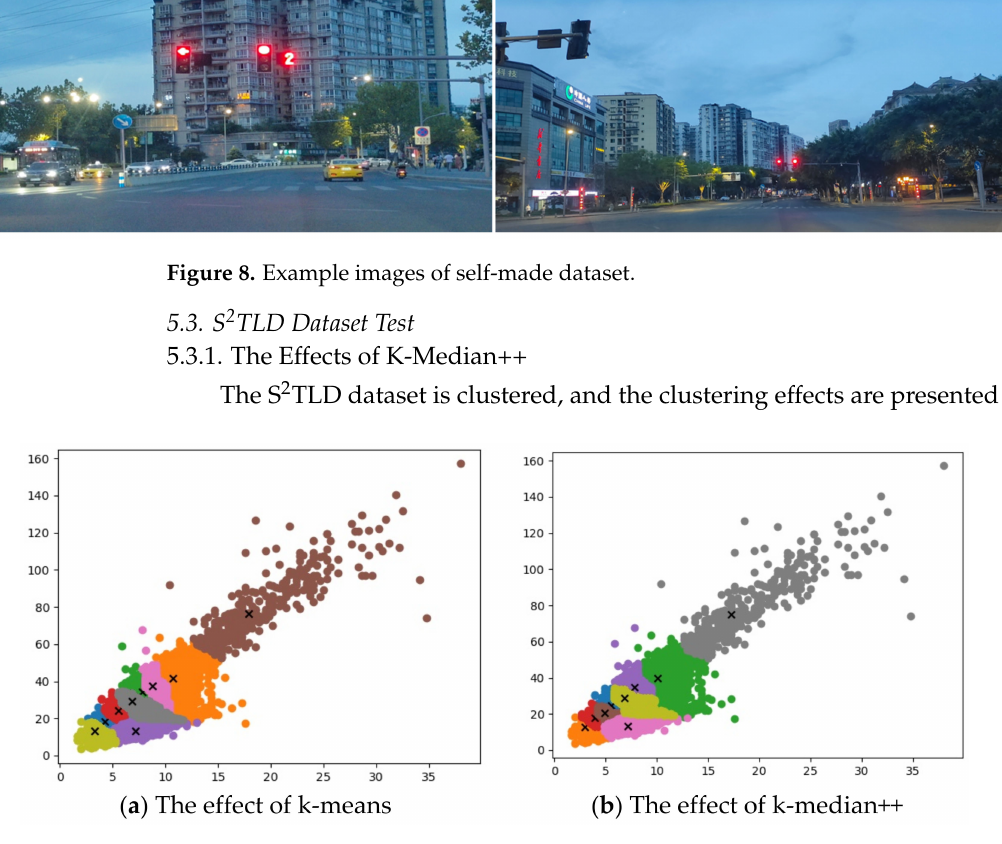
Figure 9. The effects of clustering algorithms.